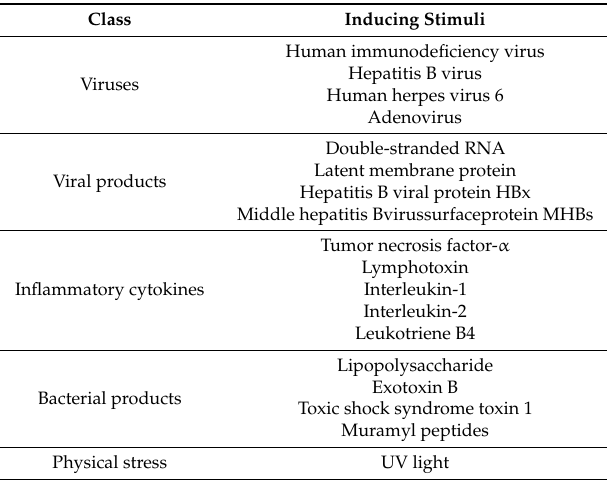
Figure 1. A brief overview of canonical and non ‐ canonical nuclear factor kappa ‐ light ‐ chain ‐ enhancer of activated B cells (NF ‐κ B) activation pathways. Canonical signaling pathway: Upon receptor engagement, I κ B kinase 1 [KK1] ( α ) and I κ B kinase 1 and I κ B kinase 2 [IKK2] ( β ) are activated through phosphorylation before proceeding to phosphorylate nuclear factor of kappa light polypeptide gene enhancer in B ‐ cells inhibitor, alpha (I κ B) members. Phosphorylation of these residues leads to Skp, Cullin, F ‐ box β‐ transducin repeat ‐ containing protein SCF ‐β‐ TrCP complex ‐ mediated rapid polyubiquitination and subsequent degradation by the 26S proteasome. Non ‐ canonical signaling pathway: upon receptor engagement, NF ‐κ B ‐ inducing kinase (NIK) is activated and directly phosphorylates and activates the IKK1 homodimer, which goes on to phosphorylate p100, leading to the partial SCF ‐β‐ TrCP ‐ mediated degradation of p100 to generate the p52 ‐ RelB complex. Table 2. A list of a few important stimuli activating NF ‐κ B.